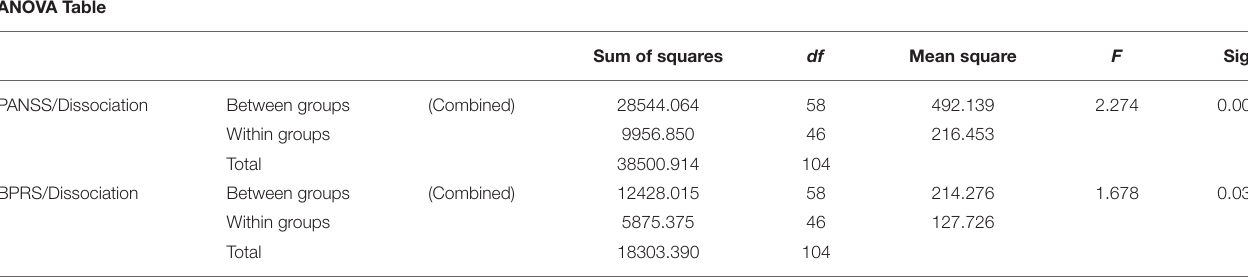
TABLE 6 | Dispersion analysis between the dissociation scale (DES) and the clinical scales PANSS and BPRS. ANOVA Table